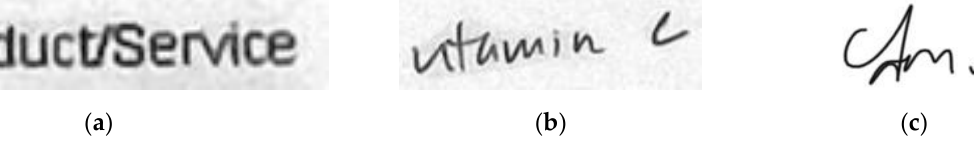
Figure 7. Sample segmented images: ( a ) printed ( b ) handwritten ( c ) non-text.